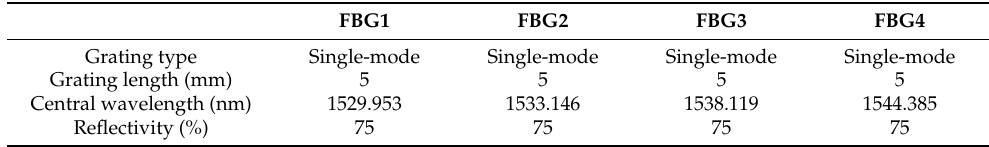
Table 6. Parameters of the FBG Sensors.